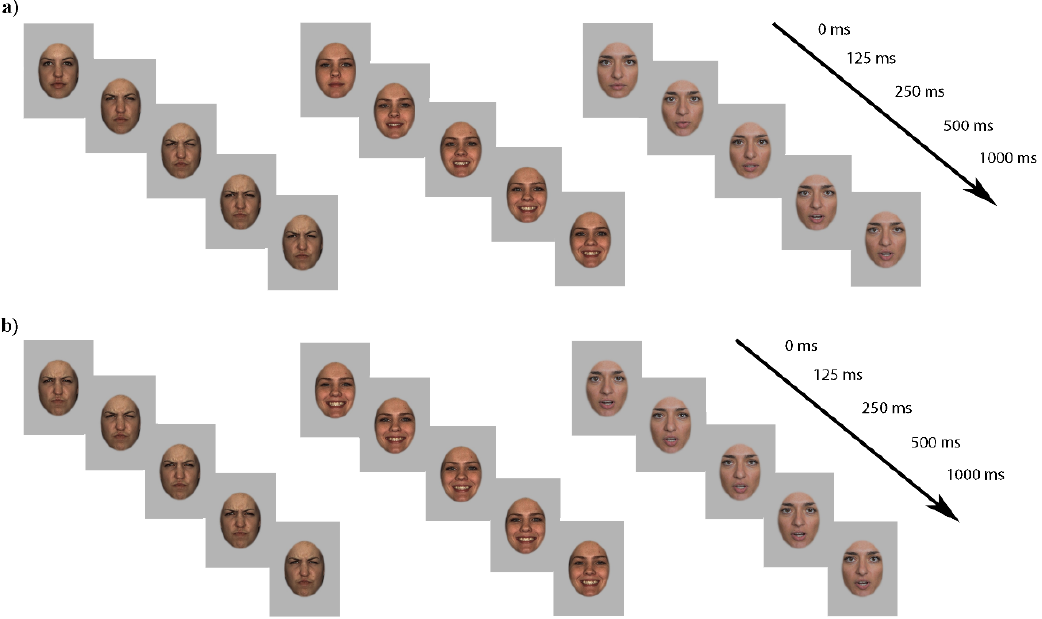
Figure 1. Examples of frames from videos used in the dynamic ( a ) and static ( b ) conditions representing the angry ( left ), happy ( central ) and neutral ( right ) expressions. In the static condition, the same picture depicting the full emotional expression remained on screen.